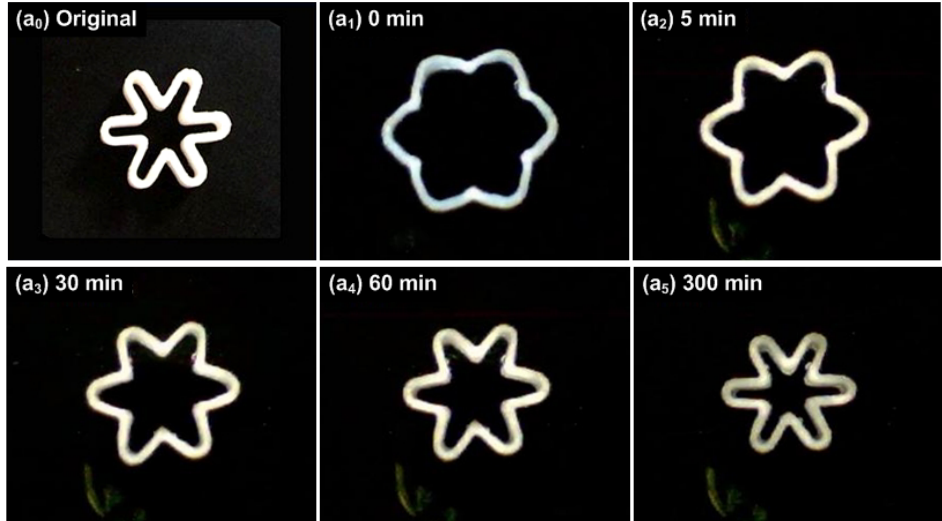
Figure 10. Shape recovery in a silicone hybrid ring filled with 70 vol % of CH upon immersing into room temperature water. (Reproduced with permission from [104]. Copyright 2013 Elsevier). ( a immersing into room temperature